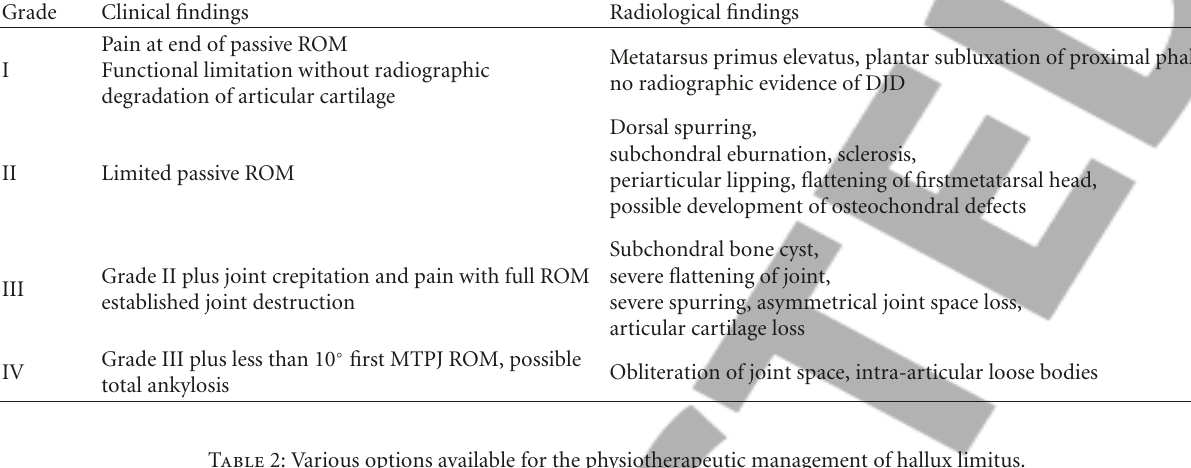
Table 2: Various options available for the physiotherapeutic management of hallux